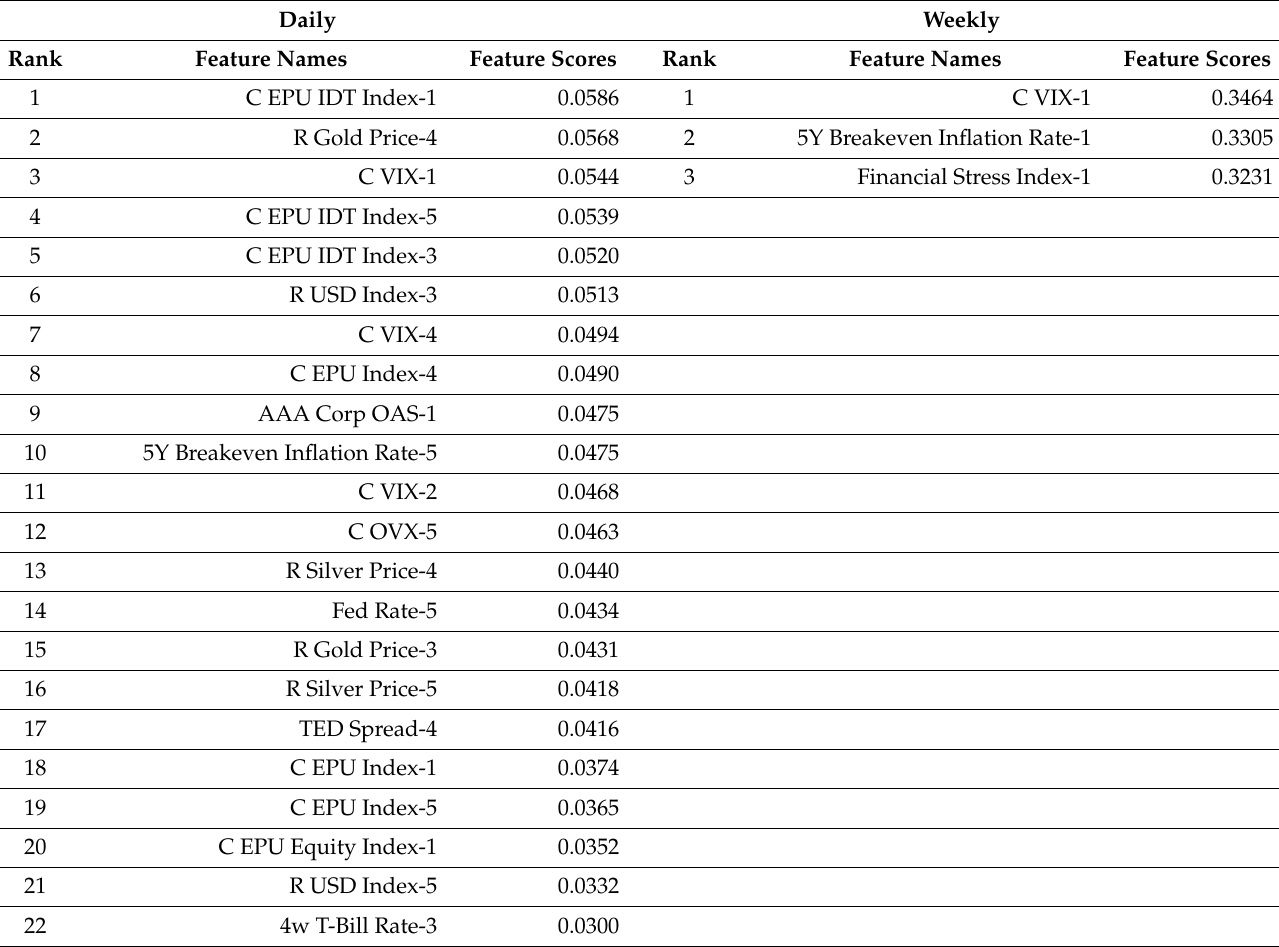
Table A2. Complete list of ranked features and their score from XG Boost. Numbers are truncated to four decimal